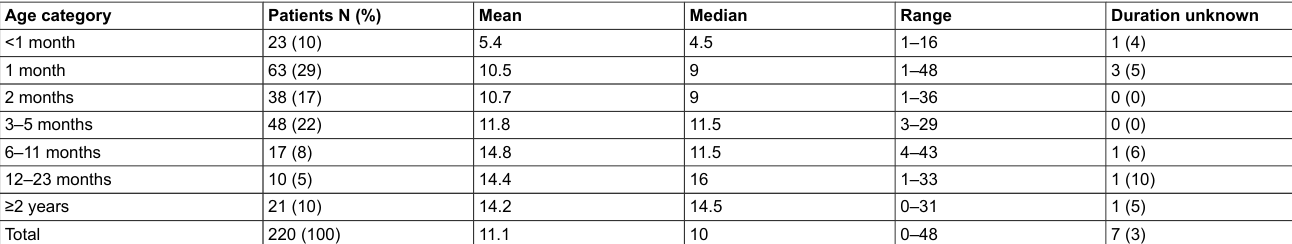
Table S3: Duration from onset of signs and symptoms to hospitalisation (in